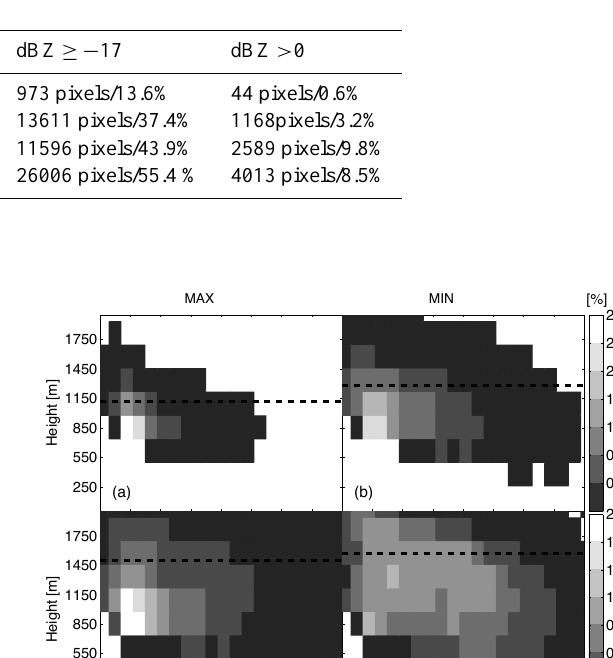
Table 1. Number and percentage of CloudSat pixels below twokm of height, at two separate regions, above two different reflectivity thresholds.